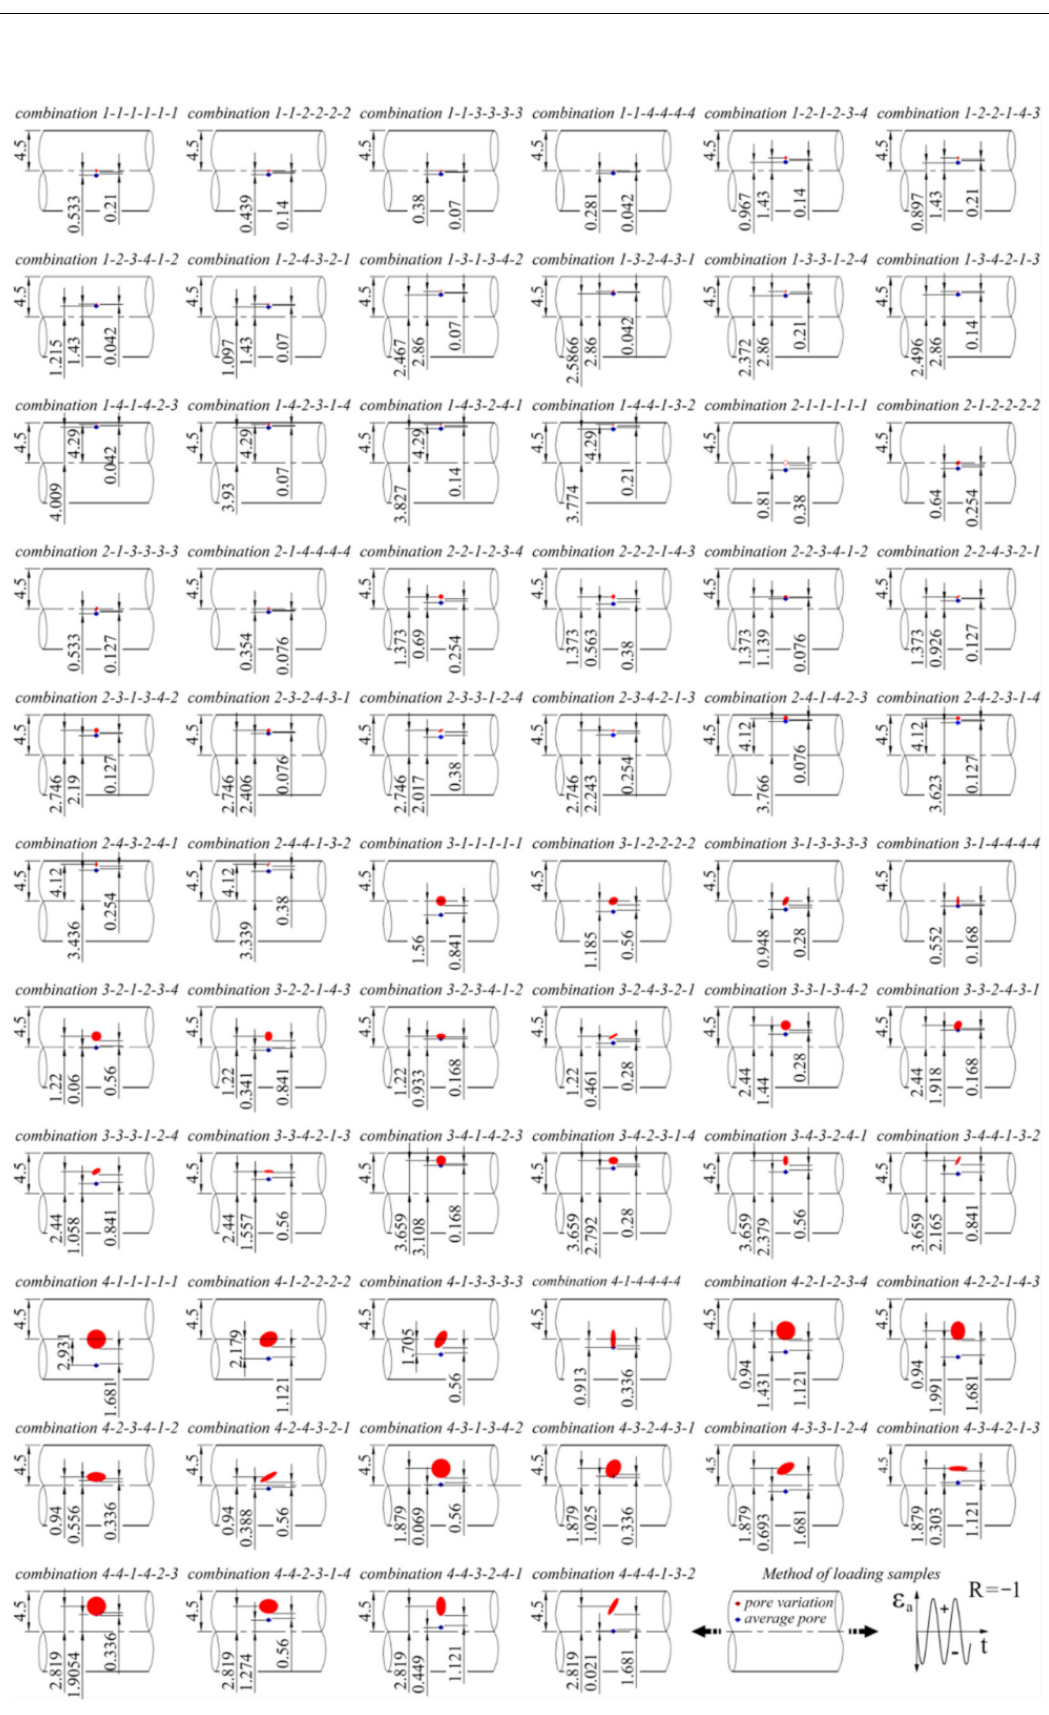
Figure 11. The full range of simulated pore combinations for the Taguchi